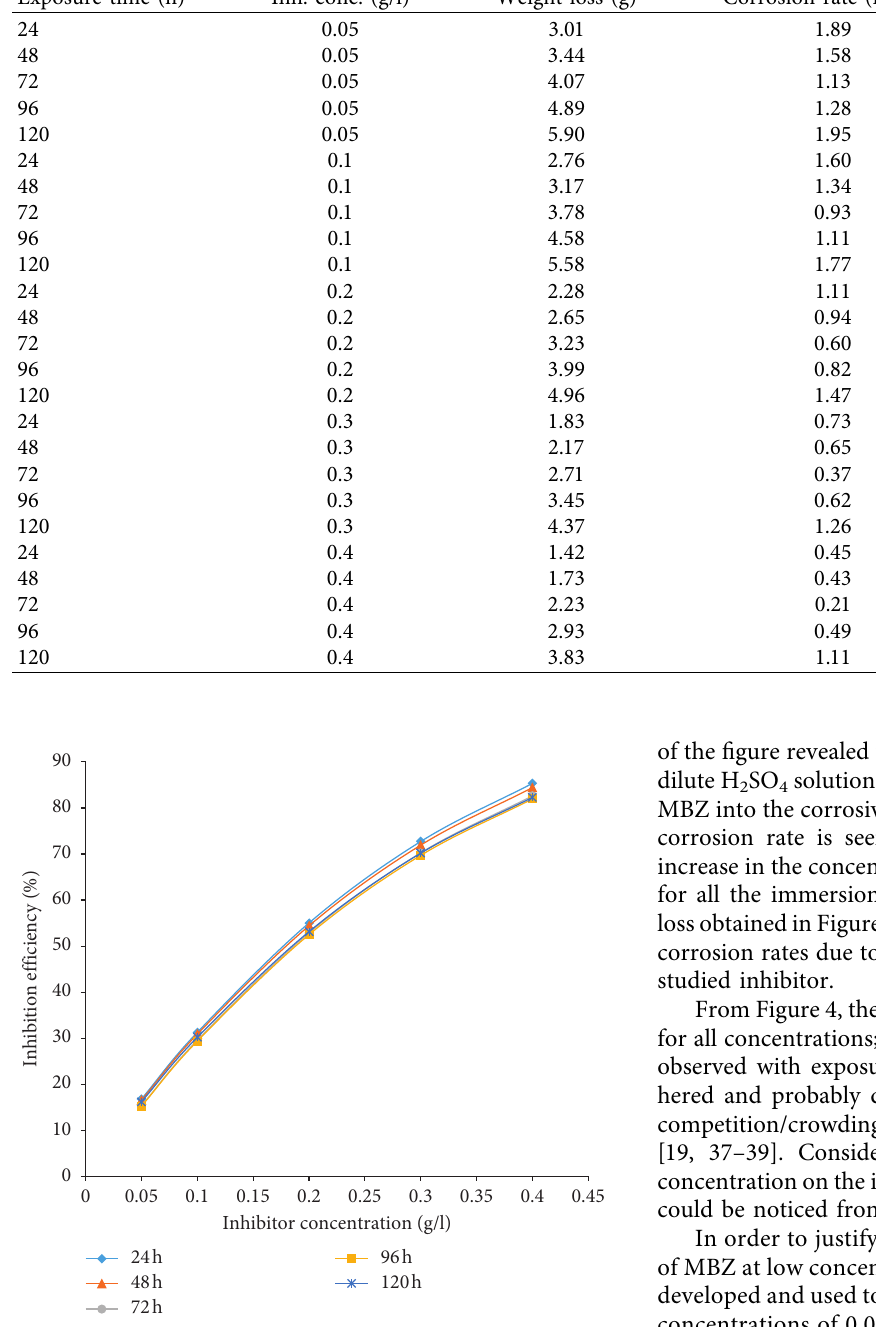
Table 2: Predicted weight loss (g) results of mild steel in the presence of small quantities of MBZ in dilute H Exposure time (h)